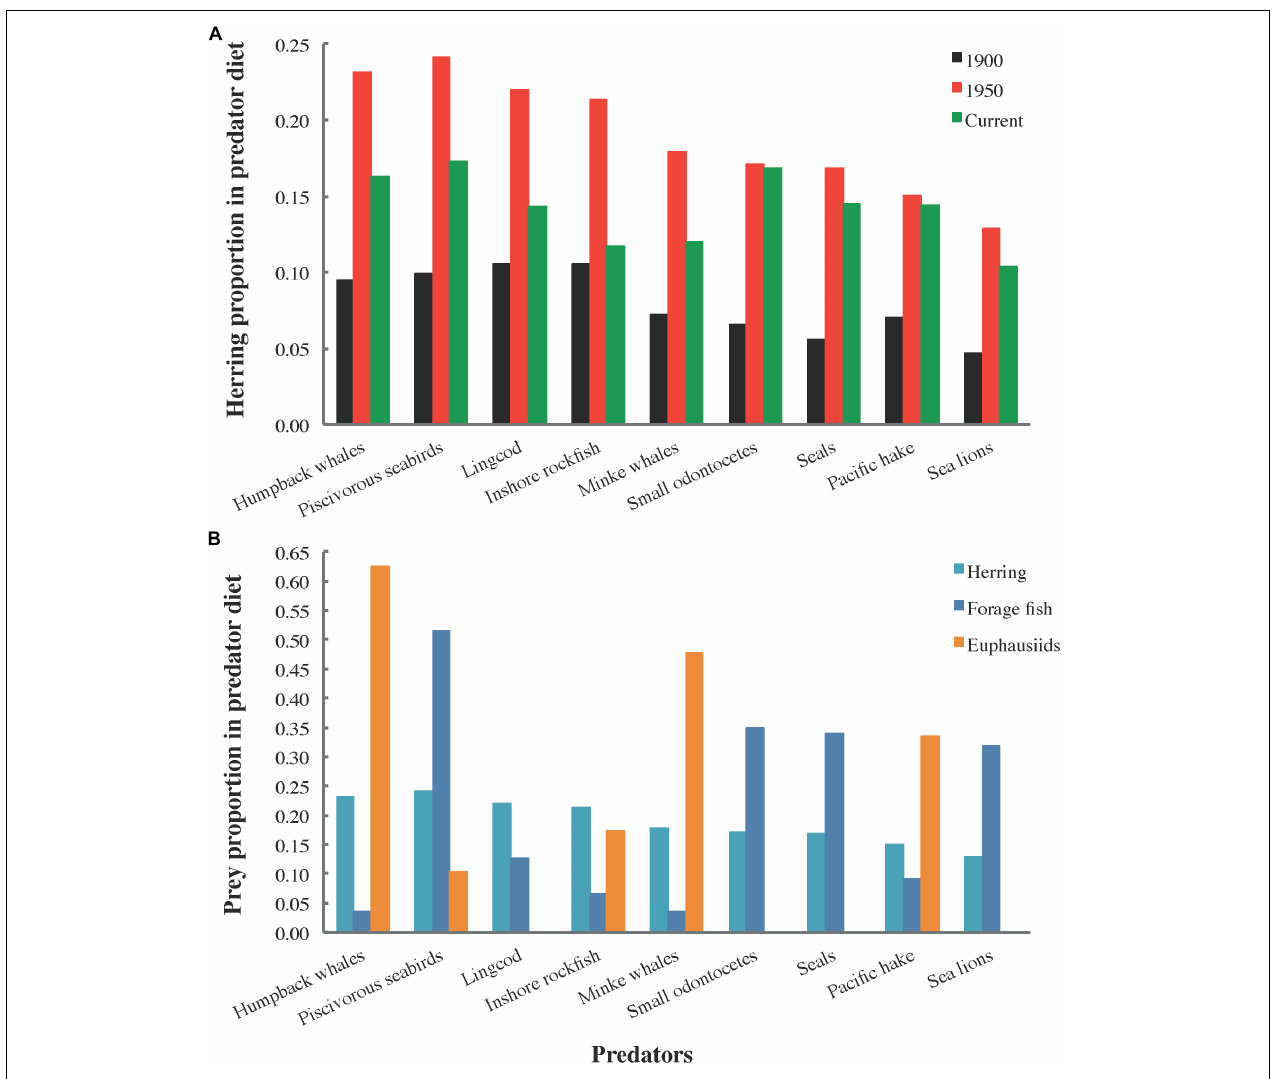
FIGURE 5 | Proportions of (A) herring by ecosystem state (1900, 1950, and current) and (B) herring, forage fish (all small pelagic fish except herring, Pacific saury, and eulachon), and euphausiids in the diets of selected predator functional